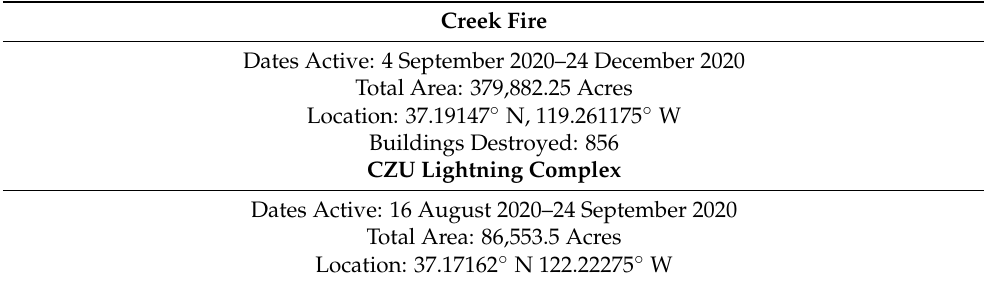
Figure 4. Maps of each study area and CAL FIRE official burnt area perimeters. Both study areas in the context of California (Left), the Creek Fire (2020) (Upper Right), the CZU Lightning Complex (2020) (Lower Right). Table 1. Summary of Creek Fire and CZU Lightning Complex burnt area characteristics.